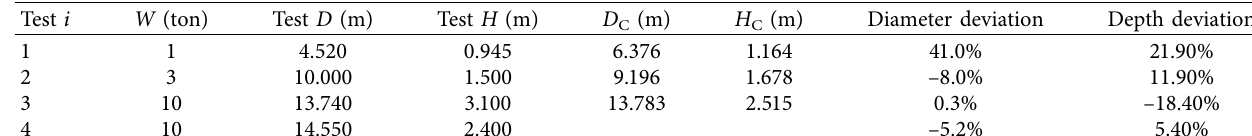
Table 12: Calculated results of the crater dimensions.